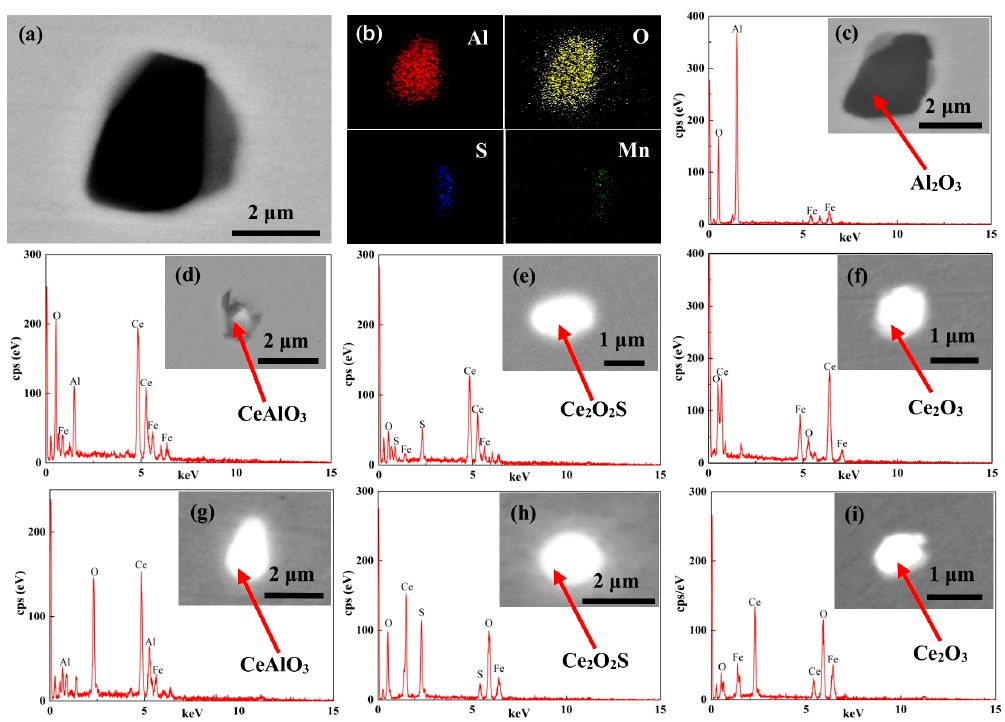
Figure 1. Morphologies and compositions of inclusions: ( a , b ) Al 2 O 3 -MnS and ( c ) Al 2 O 3 in the 0# experimental sample; ( d ) CeAlO 3 , ( e ) Ce 2 O 2 S and ( f ) Ce 2 O 3 in the 1# experimental sample; ( g ) CeAlO 3 , ( h ) Ce 2 O 2 S and ( i ) Ce 2 O 3 in the 2# experimental sample. Metals 2020 , 10 , x FOR PEER REVIEW Figure 2a represents the diameter distribution of inclusions in the 0#–2# experimental samples.